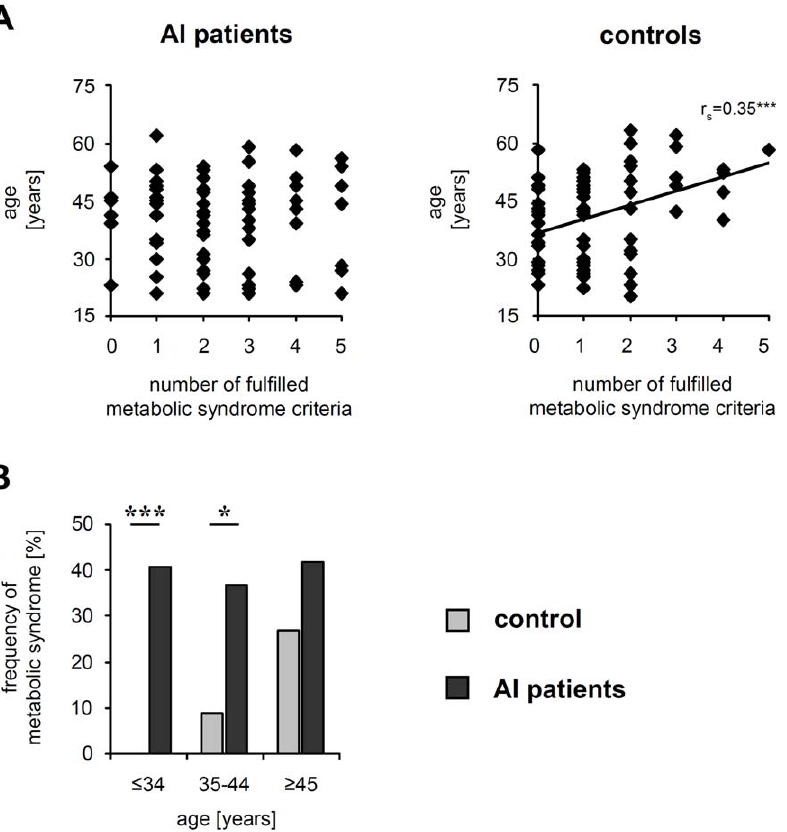
Figure 5. Correlation between age and metabolic syndrome for AI patients and control participants. (A) The correlation of age with the number of fulfilled metabolic syndrome criteria was investigated by Spearman’s rank correlation analysis for AI patients and controls. Significant correlation was found only for controls (Spearman’s rank correlation coefficient r s =0.363, *** P , 0.000). (B) The prevalence of the metabolic syndrome in AI patients and control participants in different age groups is given ( # 34 years old AI patients: n=22; # 34 years old control participants: n=36; 35 to 44 years old AI patients: n=27, 35 to 44 years old control participants: n=23; $ 45 years old AI patients: n=31; $ 45 years old control participants: n=41). Significance of differences was assessed by the Chi-square test (* P , 0.05, *** P , 0.001).